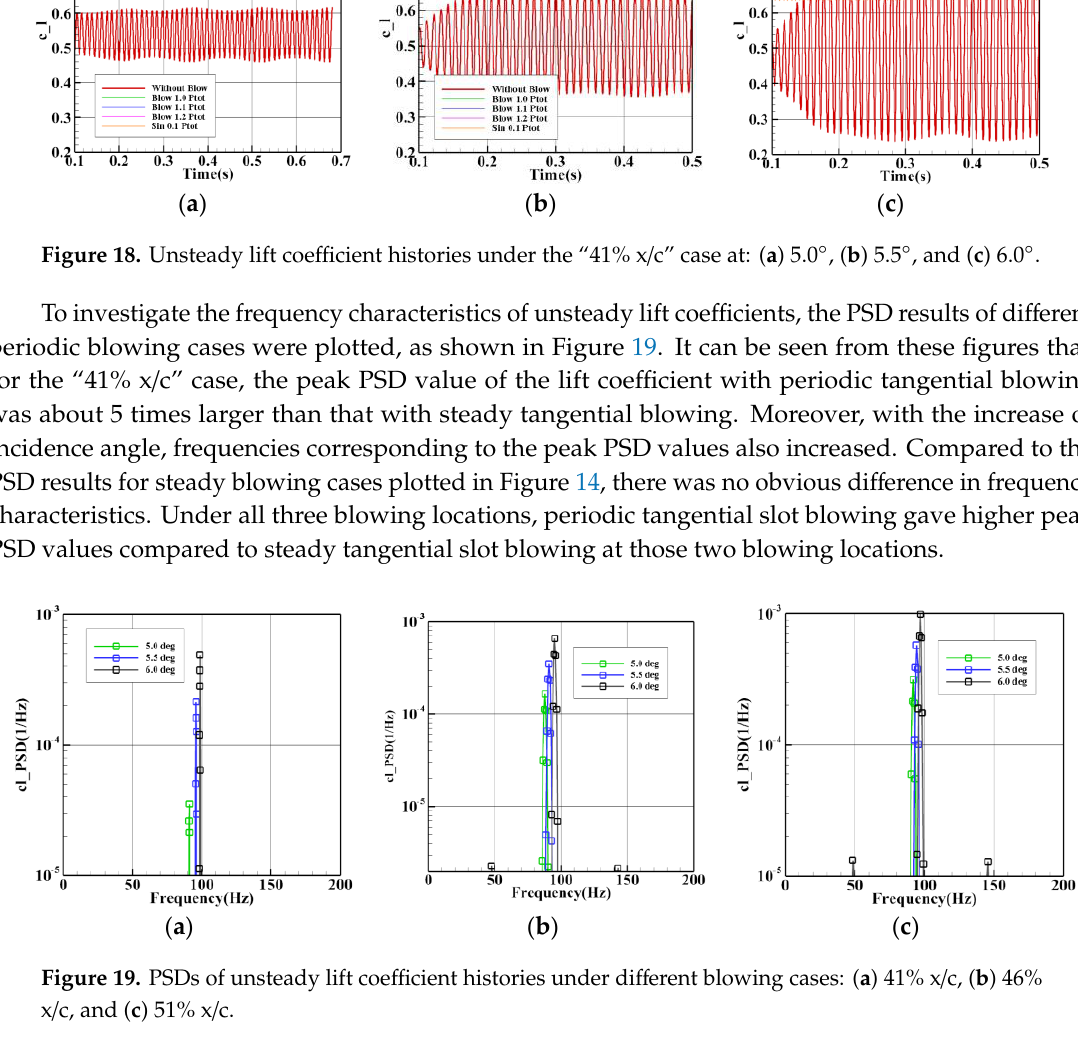
Figure 19. PSDs of unsteady lift coefficient histories under different blowing cases: ( a ) 41% x/c, ( b ) 46% x/c, and ( c ) 51% x/c.